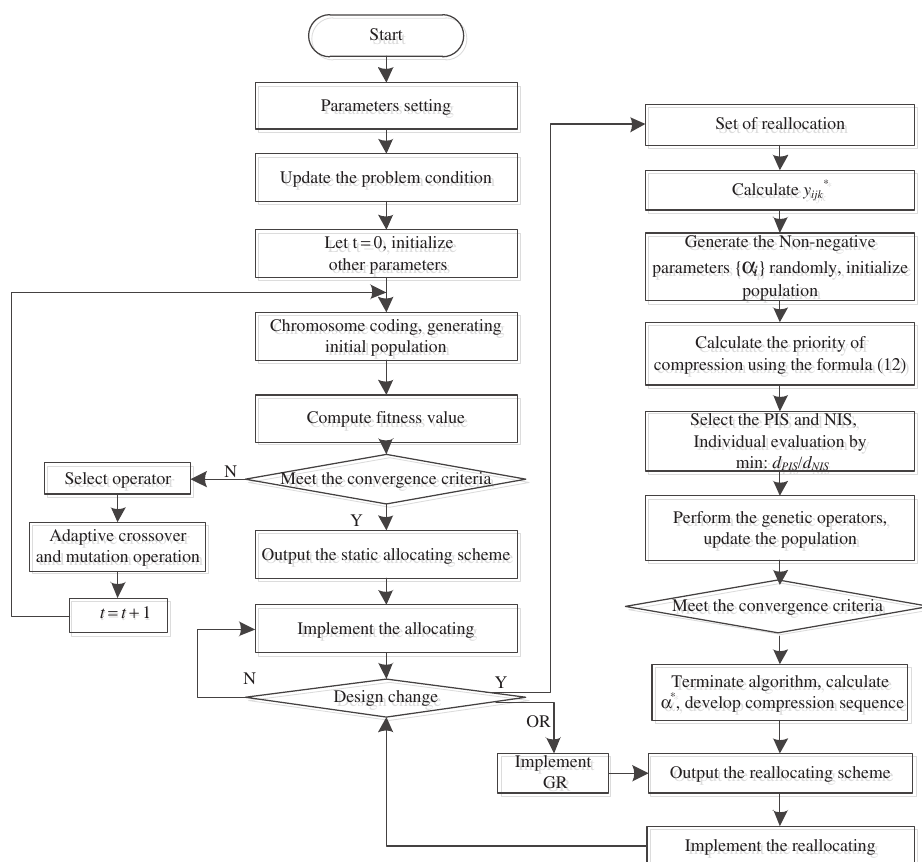
Figure 3: Flowchart of the Reallocation in Response to Design